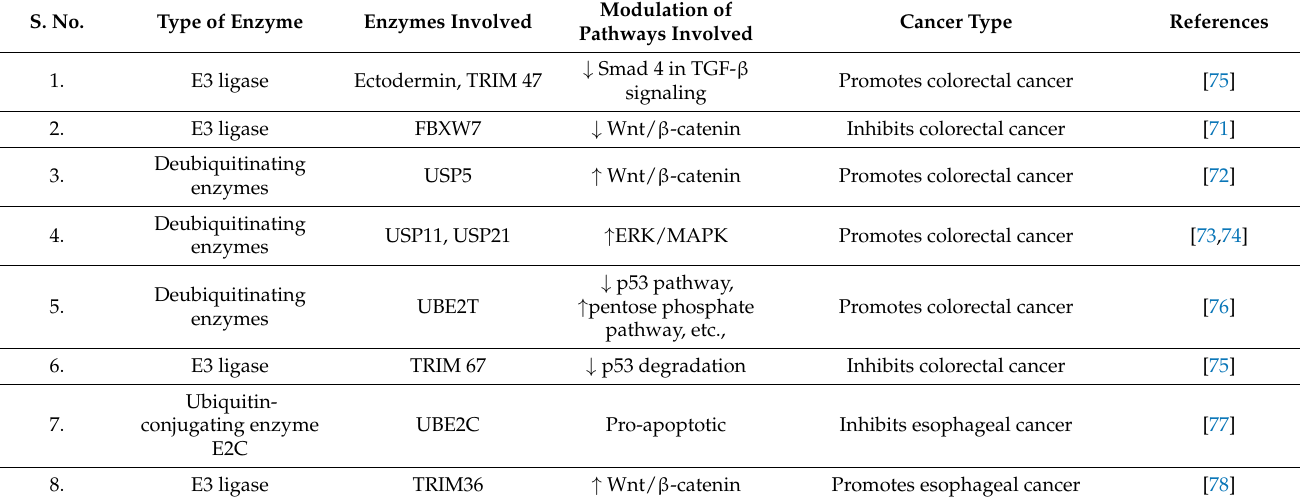
Table 1. The table summarizes various physiological roles of UPP and the enzymes/proteins involved in a cancer type. S.